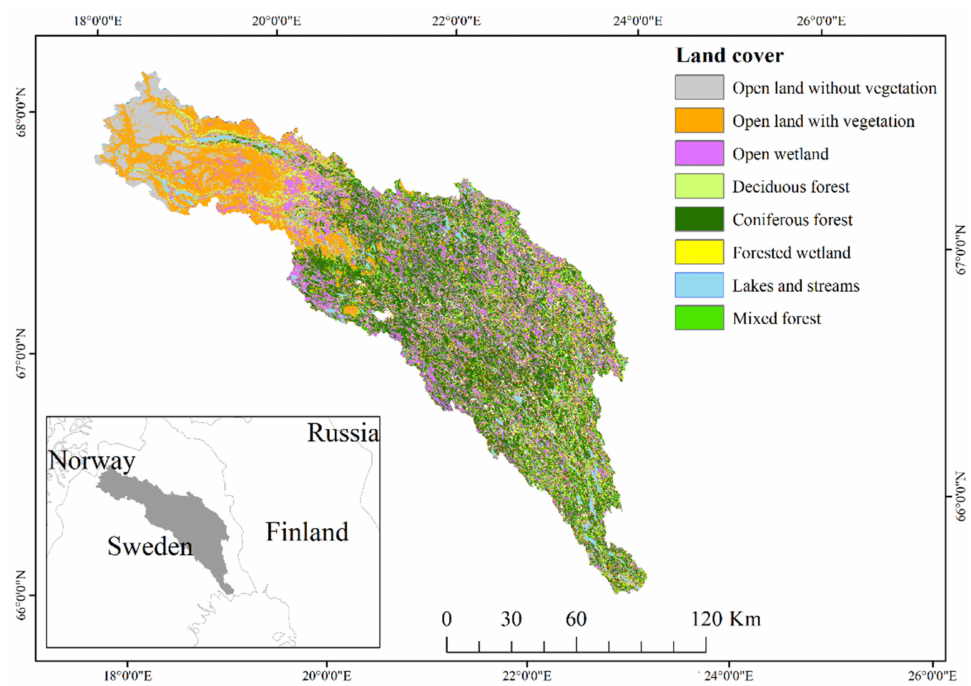
Figure 1. Location, extent and land cover classes of the study area. Land cover data from Swedish National Land Cover data (Nationella Marktäckedata or NMD, 2020). Table 1. Distribution of vegetation height classes over all land cover classes except water bodies in the Kalix River